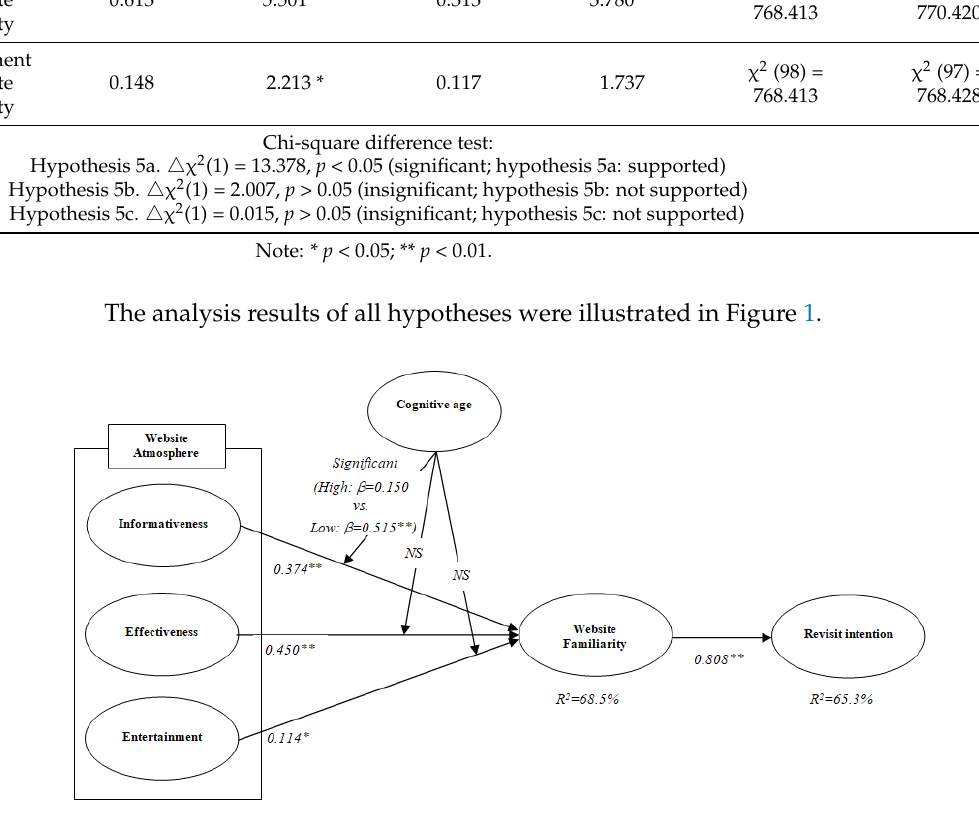
Figure 1. Hypotheses test results.